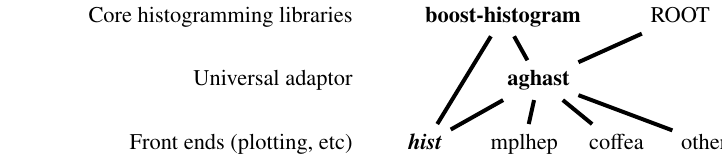
Figure 2. Plan for Scikit-HEP projects and relationship between